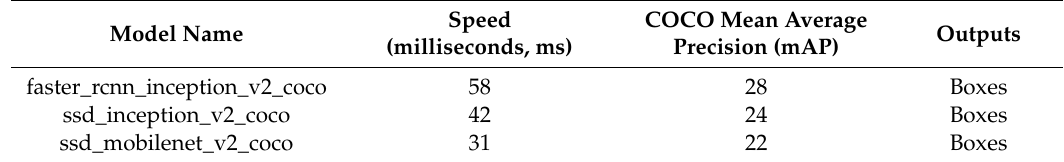
Table 2. Properties of object detection